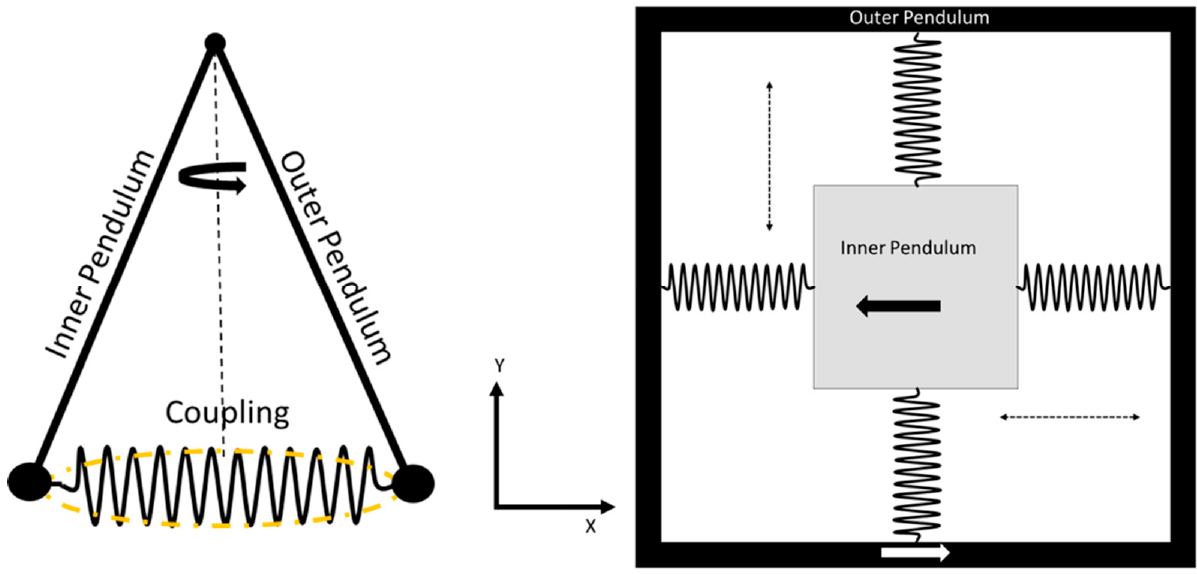
Figure 21. Schematic diagram of dual Foucault pendulum gyroscope. Two Foucault pendulums vibrate in antiphase motion.